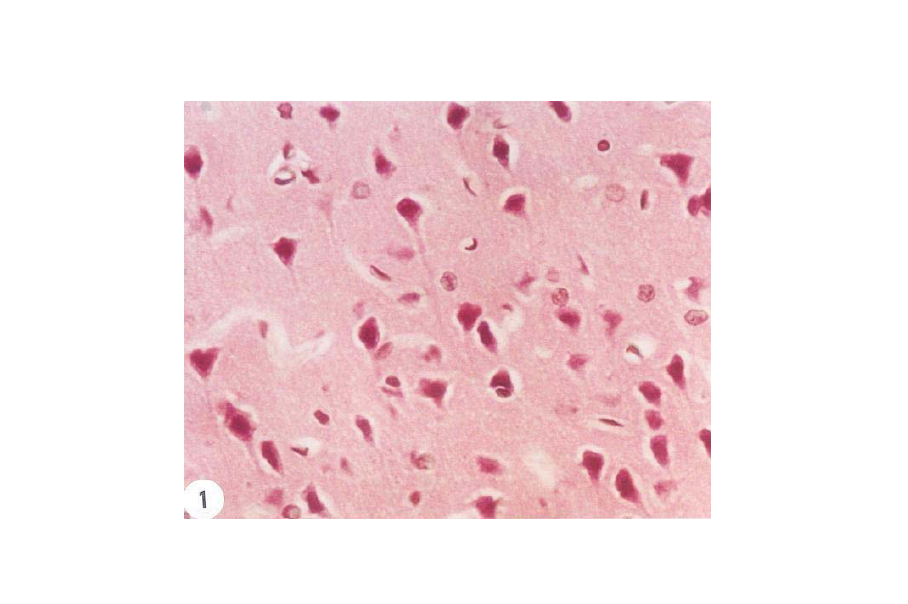
Figure 1. Cerebral cortex of a control rat showing normal neurons mostly with polygonal shaped cyton and dense nuclei. Note a few neurons with round cell bodies (H&E). (X400)